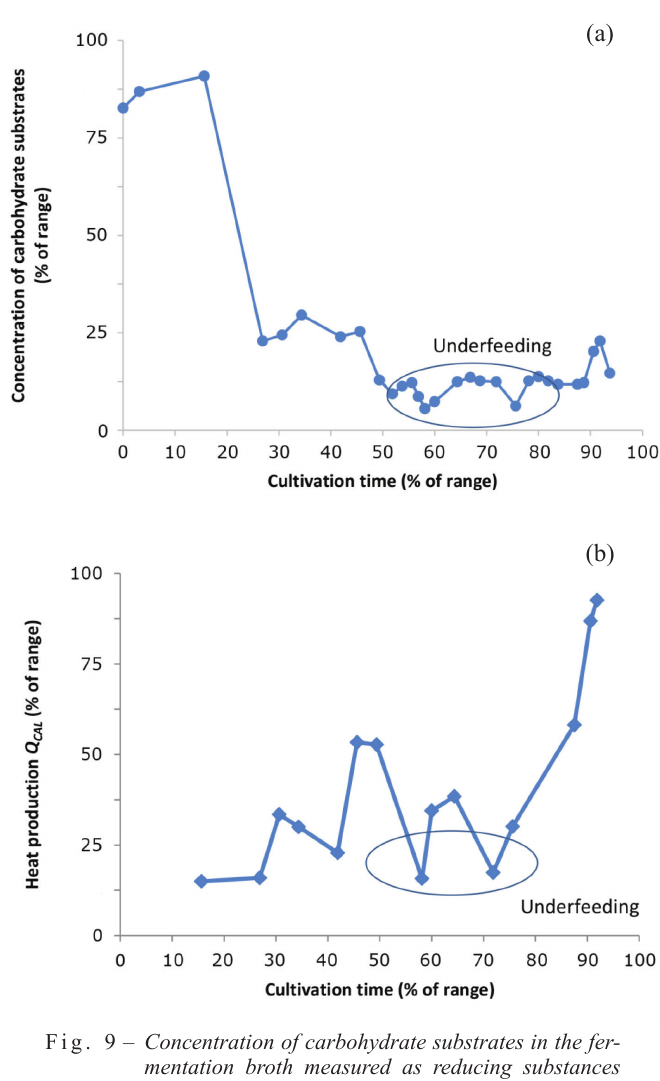
Fig. 9 – Concentration of carbohydrate substrates in the fer- mentation broth measured as reducing substances (a) and calorimetric measurements (b) in cultivation